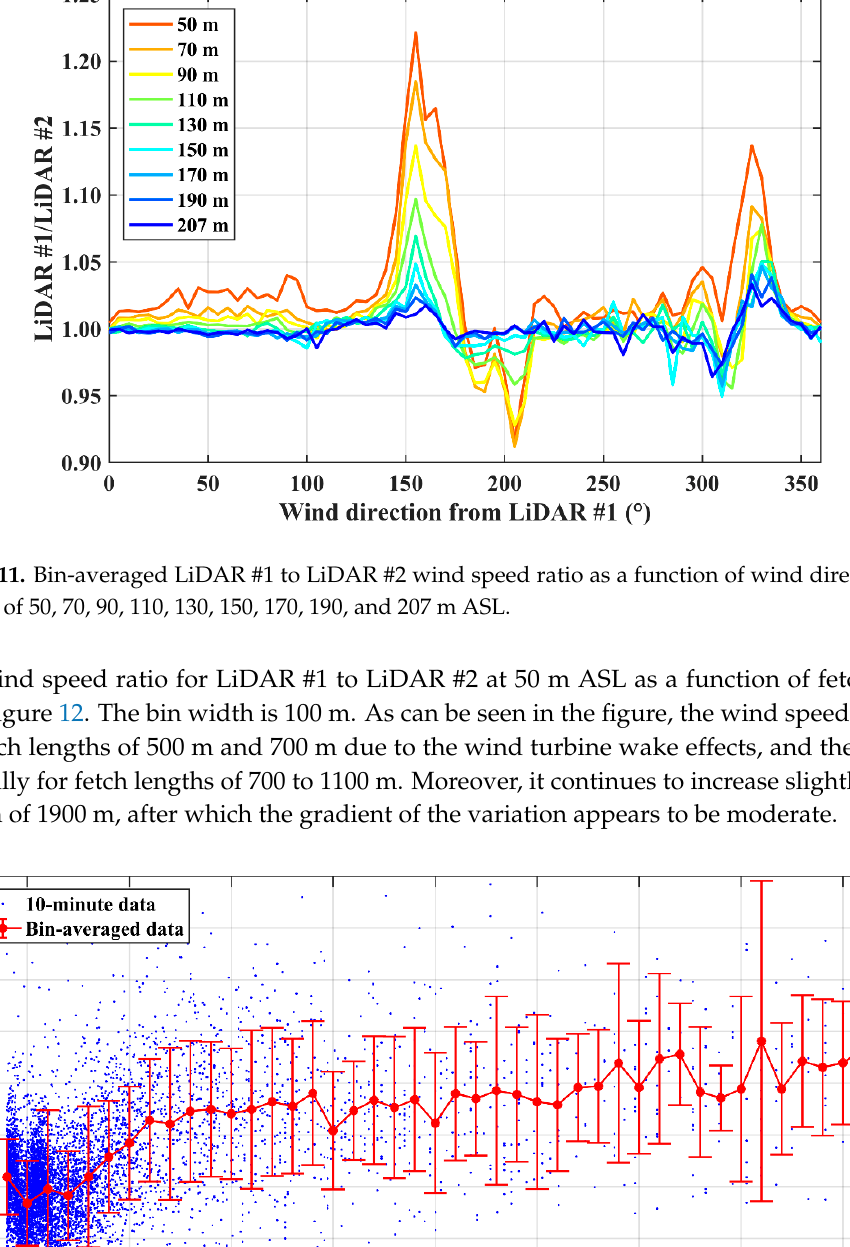
8 of 14 Figure 10. LiDAR #1 to LiDAR #2 wind speed ratios at 50 m above sea level (ASL) as a function of wind direction. Only LiDAR #2 wind speeds greater than 2 m/s were used in the analysis. The strength of the wake and fetch effects was found to depend significantly on height when the same relationships were illustrated with the LiDAR observations at different heights. Figure 11 shows the same relationships as Figure 10, but the relationships for all heights are depicted because, in this figure, the authors considered the height dependency of the wake and fetch effects. Figure 11 shows